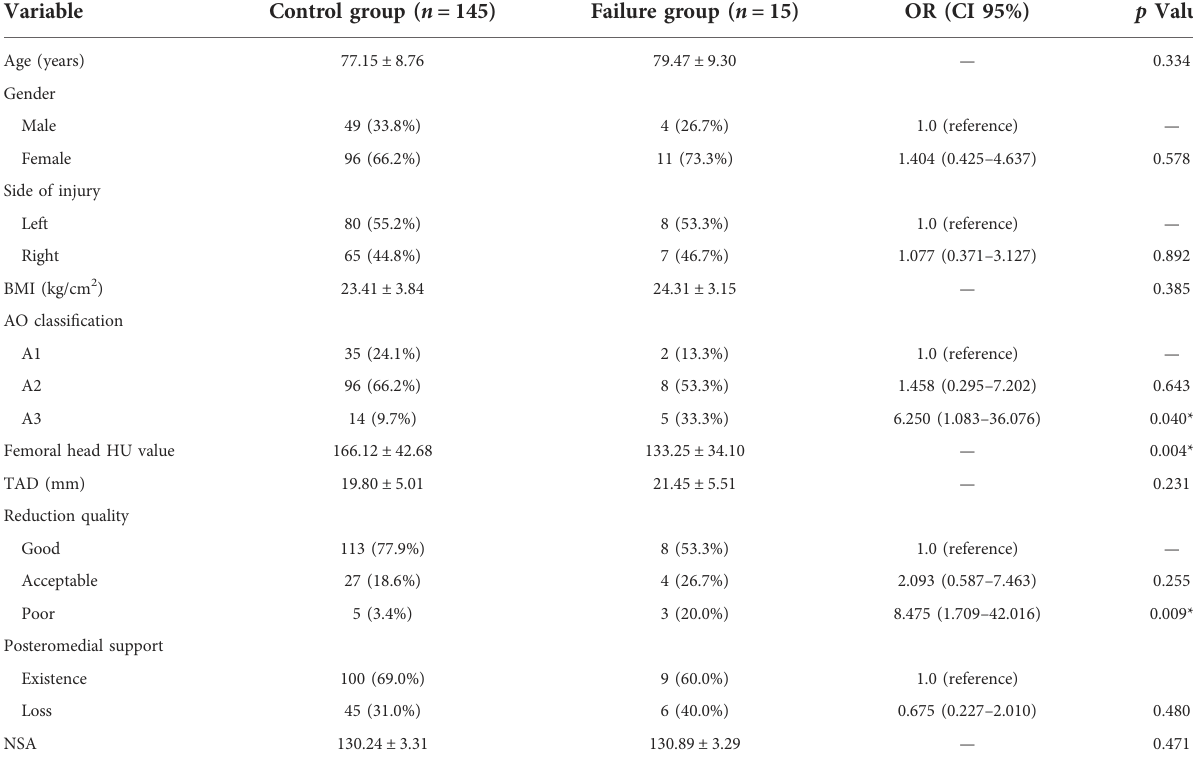
TABLE 2 The comparison of patient characteristics between control group and failure group.